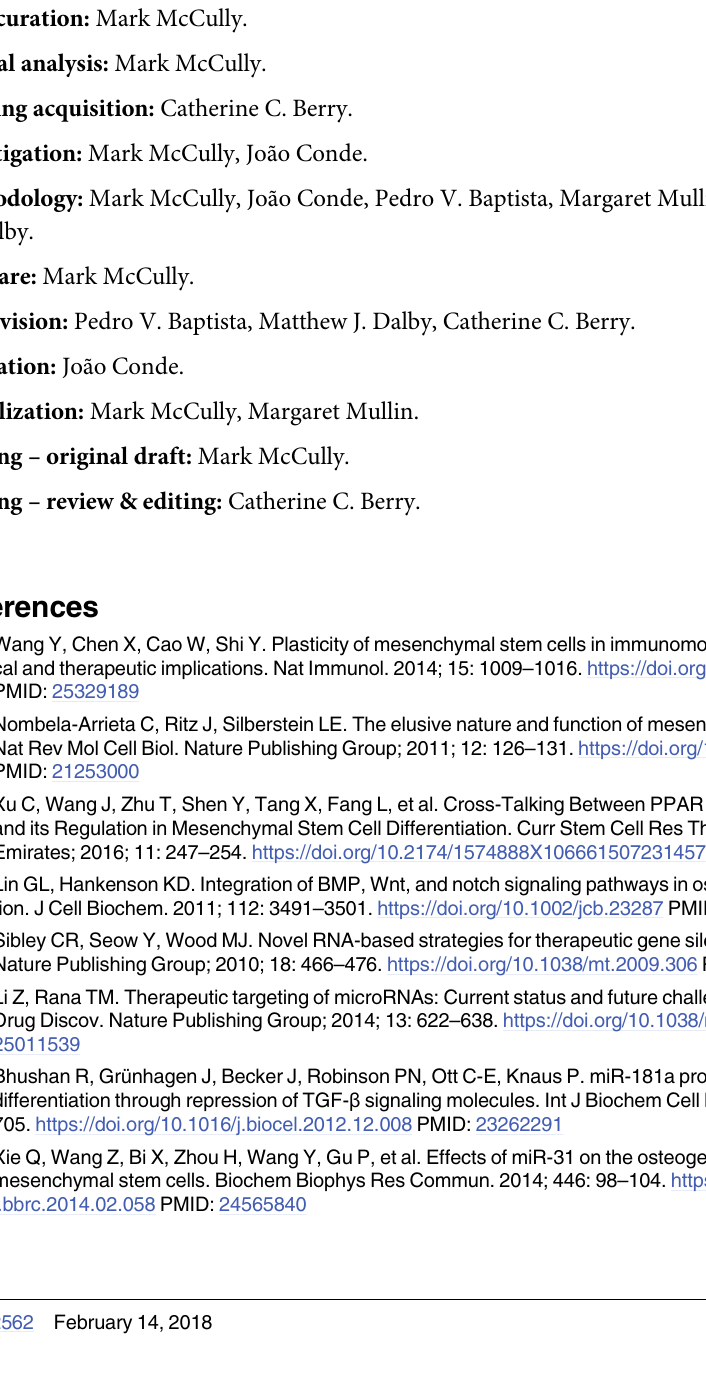
S2 Table. List of fluidigm primers used in this study. Primer list used for fluidigm analysis, detailing the gene function and the forward and reverse sequences used. Those with (cid:3) indicate housekeeping